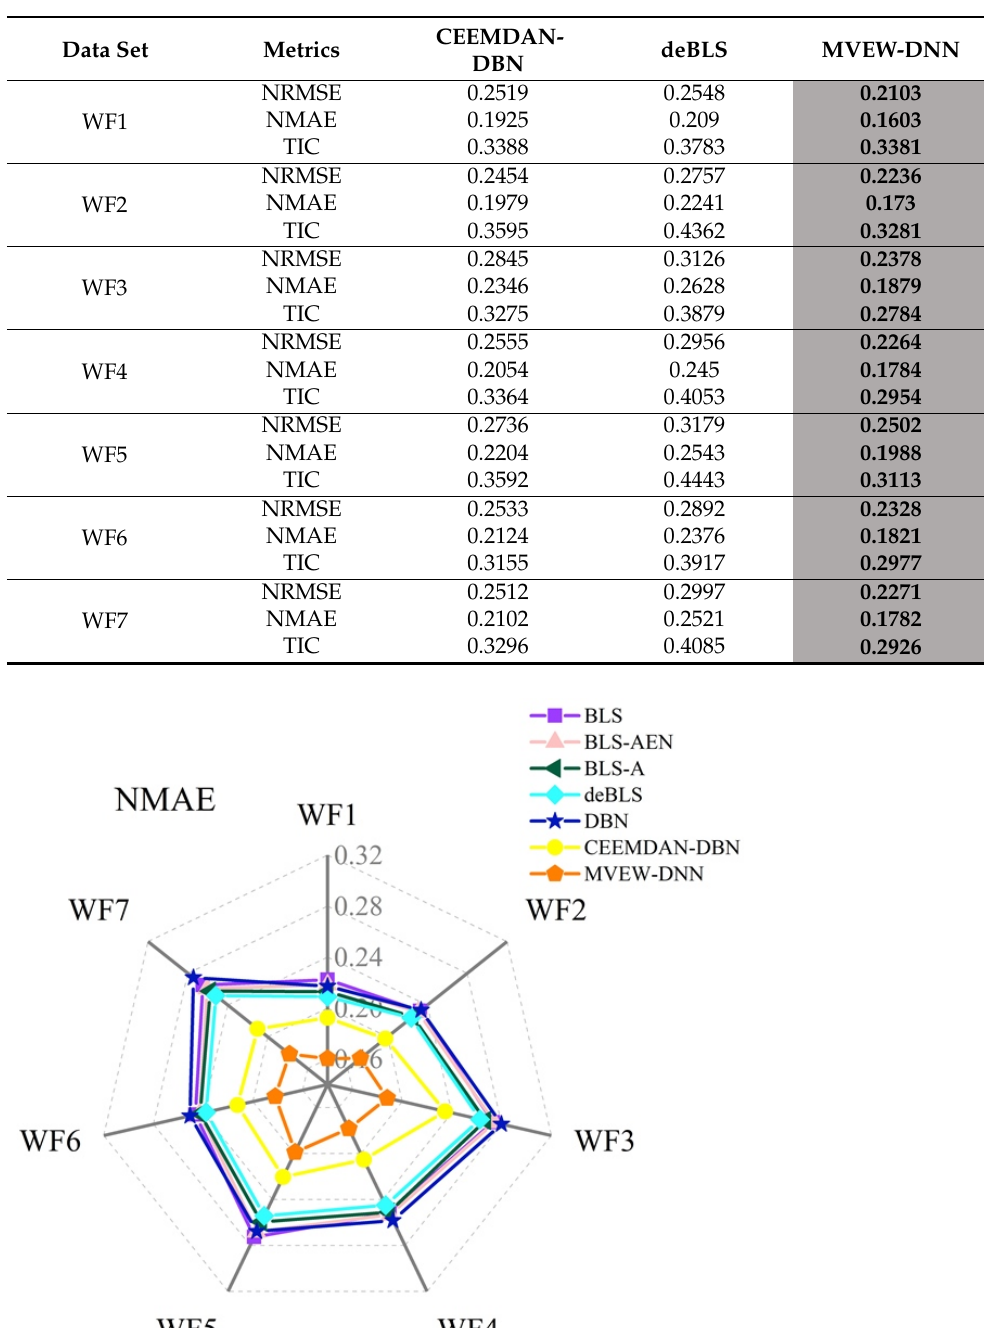
Table 4. The results of CEEMDAN-DBN, deBLS, and the proposed MVEW-DNN model.